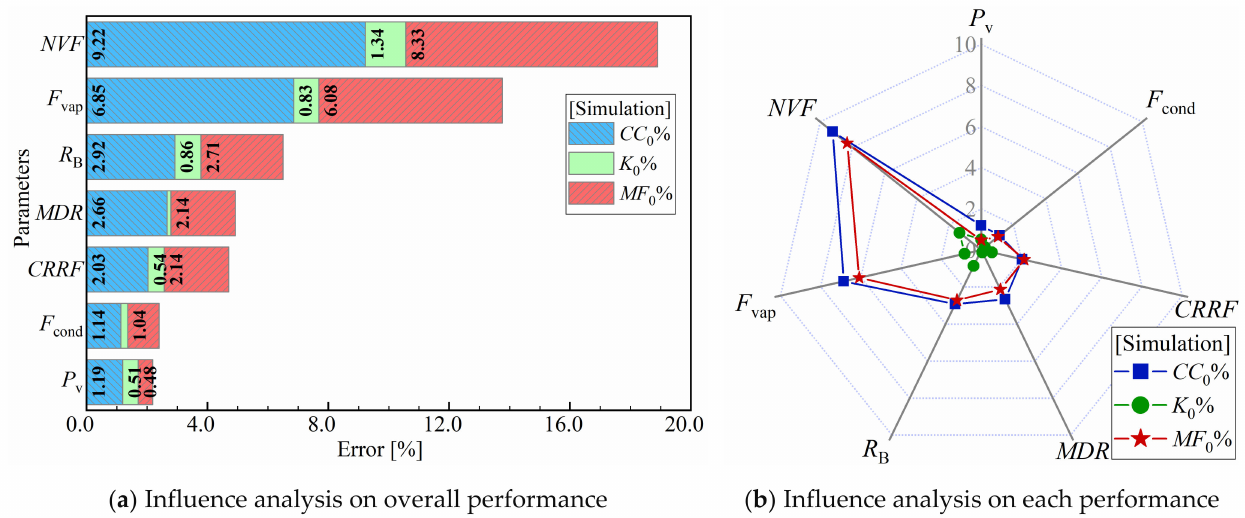
Figure 9. Influence degree of all cavitation parameters on capacity constant, torque ratio, and mass flow rate of torque converter at